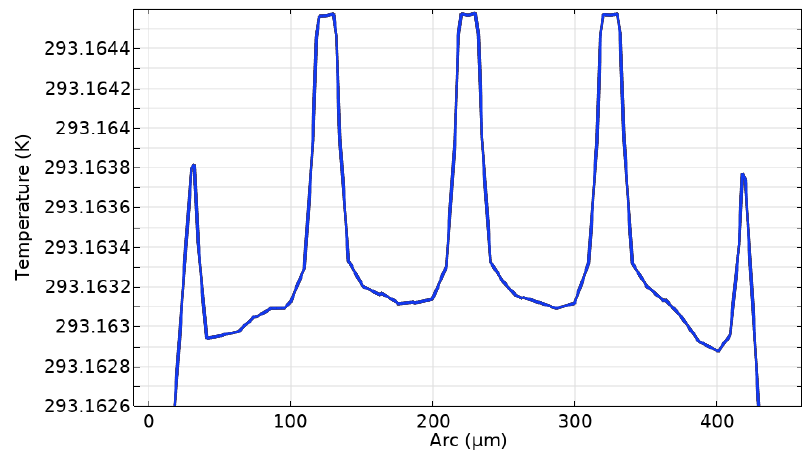
Figure 8. Temperature curve along the horizontal midline of the 1 mm channel’s exit.